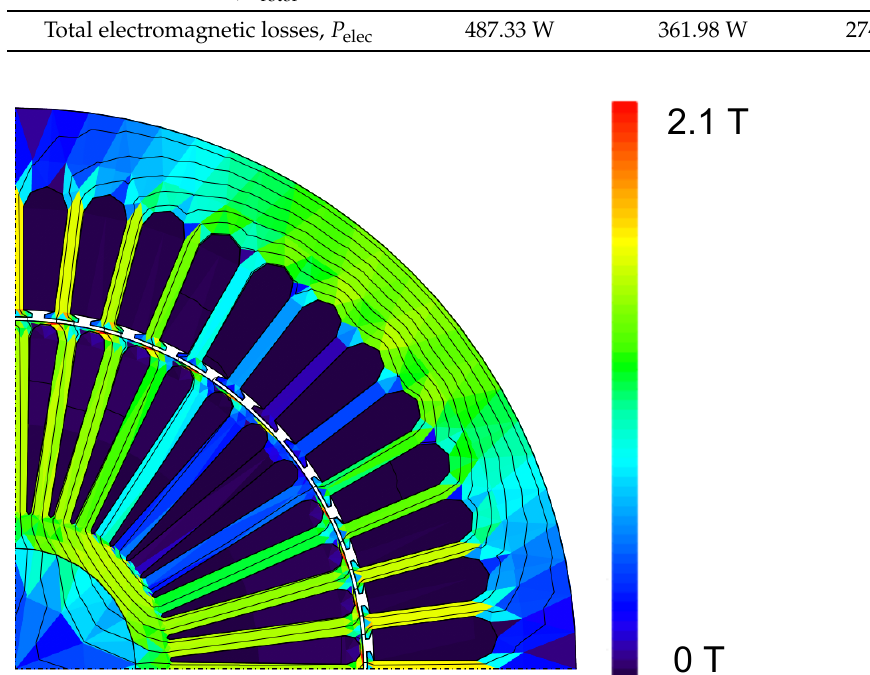
Figure 9. Flux density distribution of the optimal solution from the proposed surrogate optimization routine–multivariate optimization